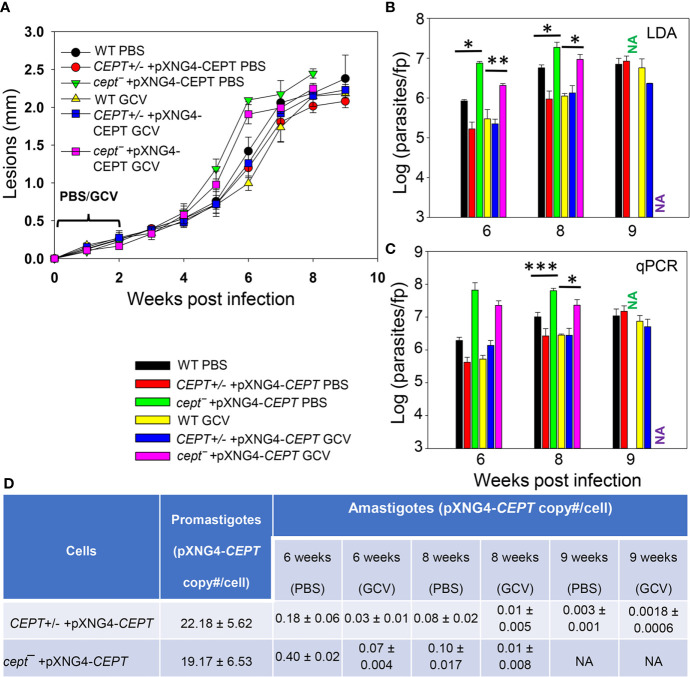
CEPT is dispensable for L. major amastigotes. BALB/c mice were infected in the footpads with stationary phase promastigotes and treated with either GCV or PBS from day 1 to day 14 post infection as described in Materials and Methods. (A) Footpad lesions were recorded weekly. (B, C) Parasite numbers in the infected footpads were determined at the indicated times by limiting dilution assay (B) and qPCR (C). (D) The pXNG4-CEPT copy numbers in promastigotes and amastigotes (#/cell ± SDs) were determined by qPCR. The 9 weeks data for cept¯ +pXNG4-CEPT amastigotes were not available (NA) because the infected mice had reached the humane endpoint at 8 weeks. Error bars represent standard deviations (*p < 0.05, **p < 0.01, ***p < 0.001).